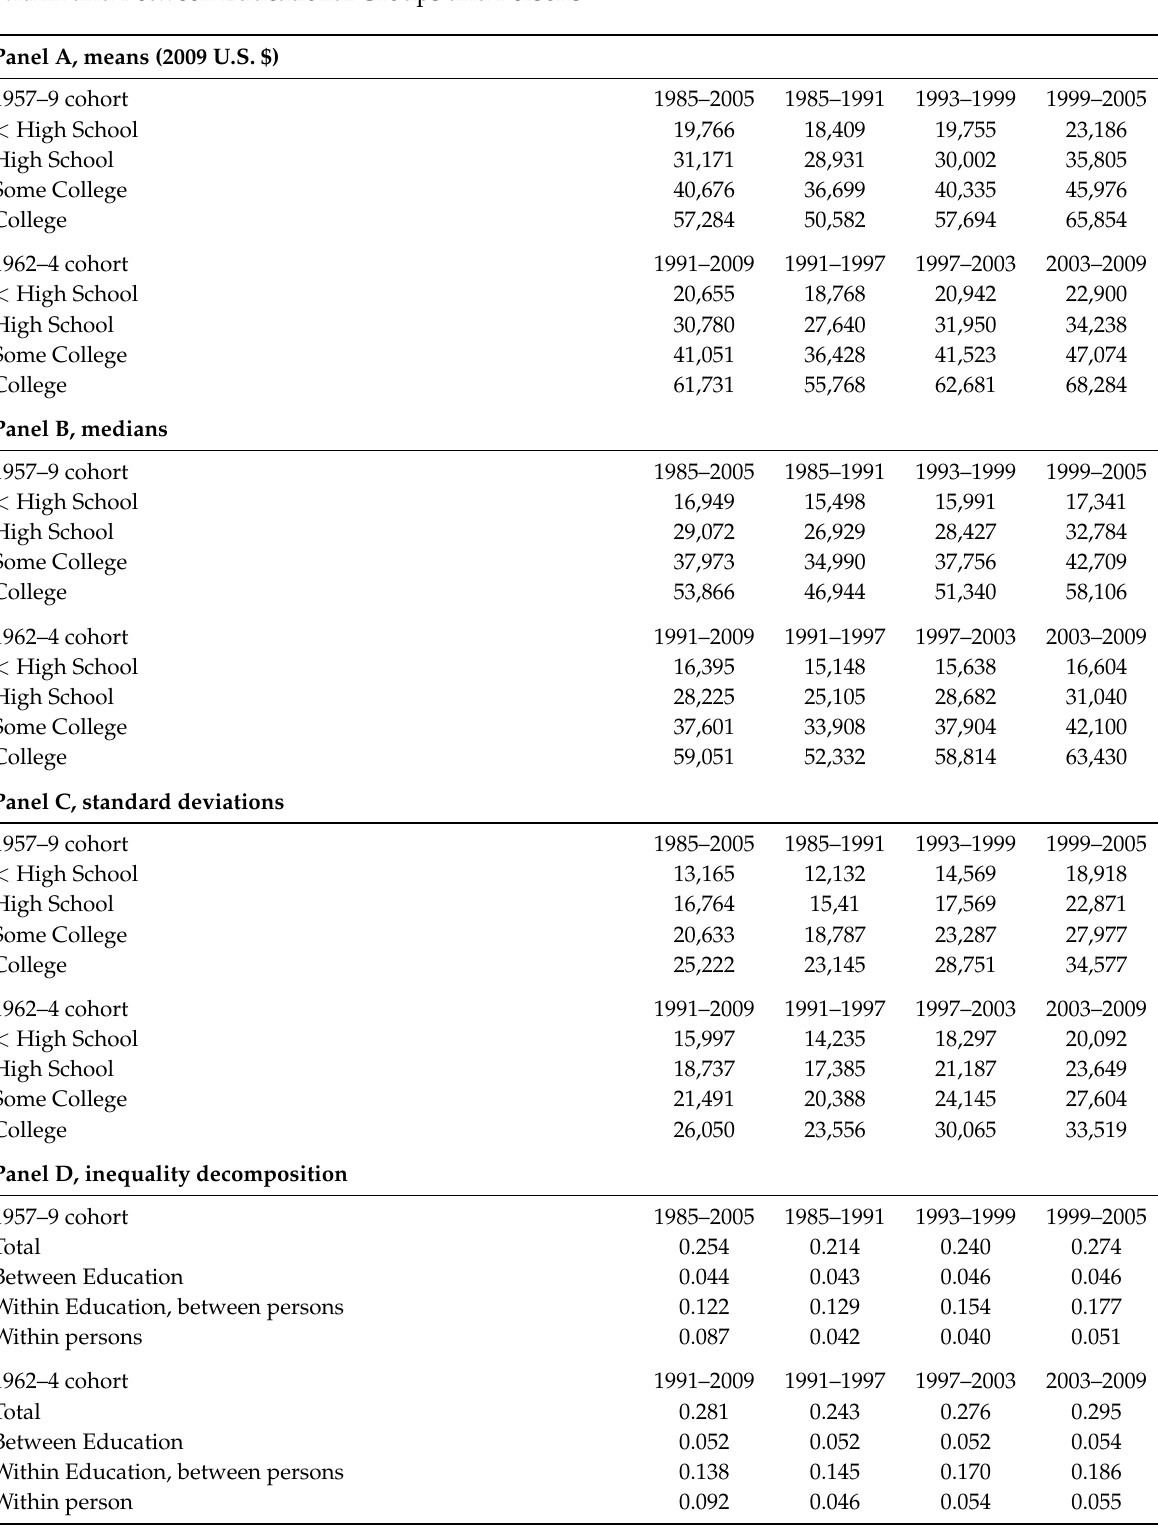
Table 4: Means and Standard Deviations of Income by Educational Group and Decomposition of Inequality Within and Between Educational Groups and Persons Panel A, means (2009 U.S.